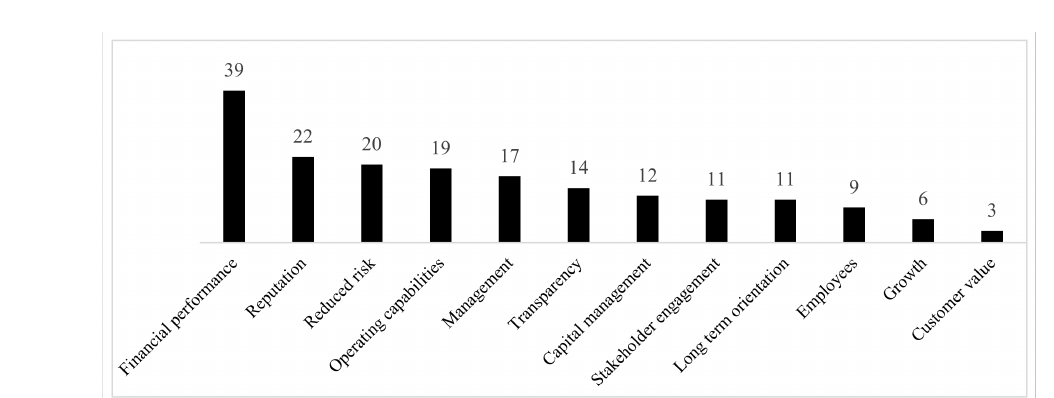
Figure 1. Frequencies of the ESG impact categories—created by